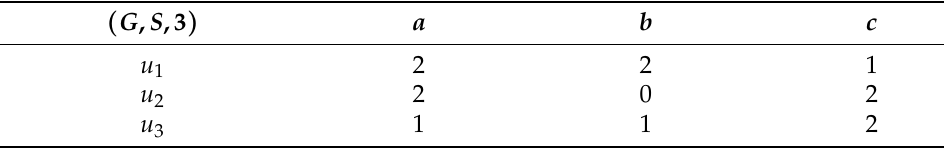
Table 16. The 3-Soft Set of ( G , S ,3 )